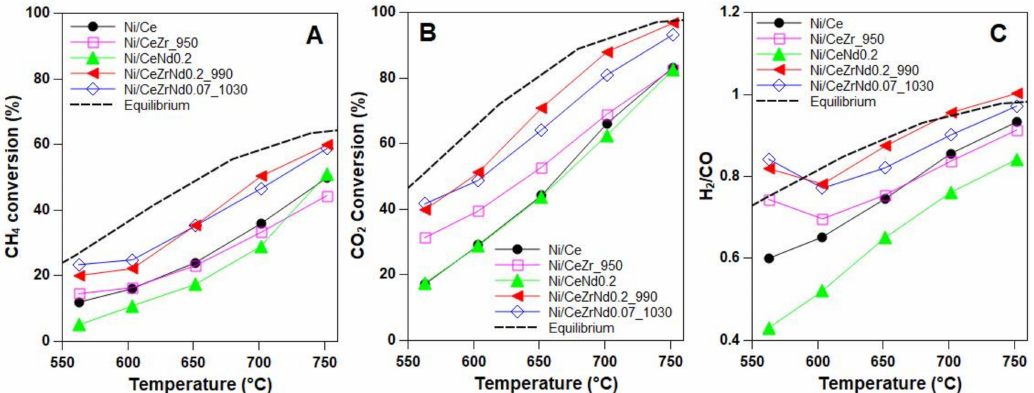
Figure 8. Catalytic activity of catalysts investigated: ( A ) CH 4 conversion, ( B ) CO 2 conversion and ( C ) H 2 /CO ratio.